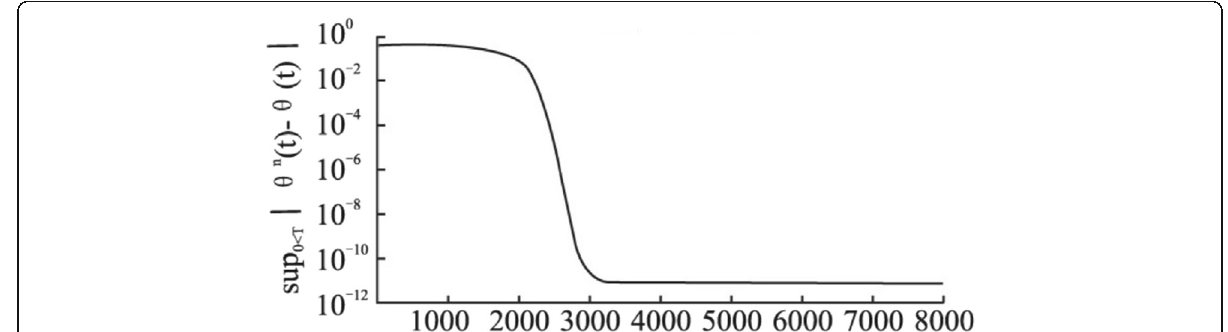
Fig. 5 Iterative output